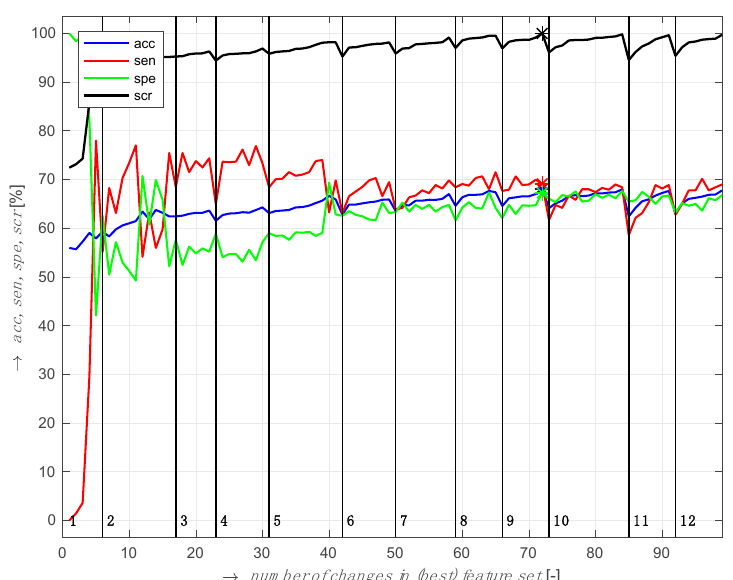
Figure 4. EEG feature selection using sequential forward floating selection (SFFS) on the training dataset, validated using 10-fold cross-validation.